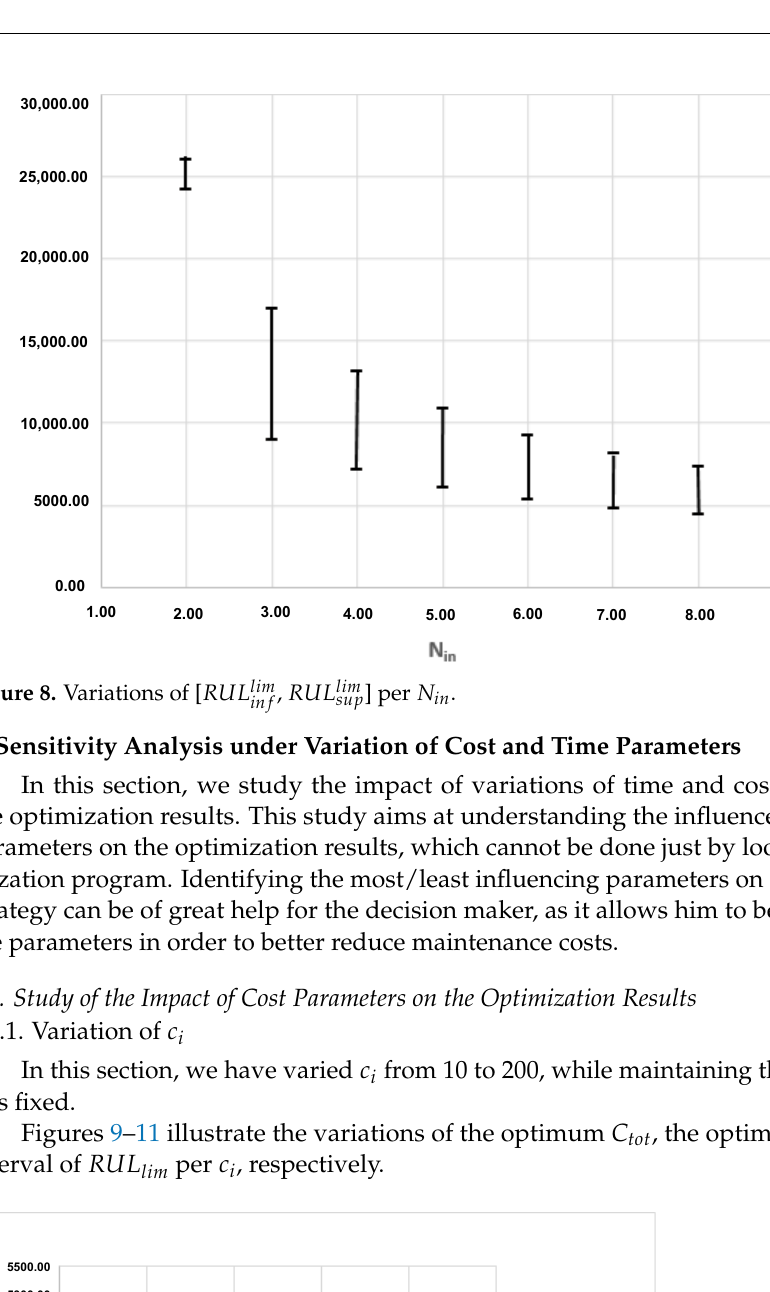
Figure 8. Variations of [ RUL lim